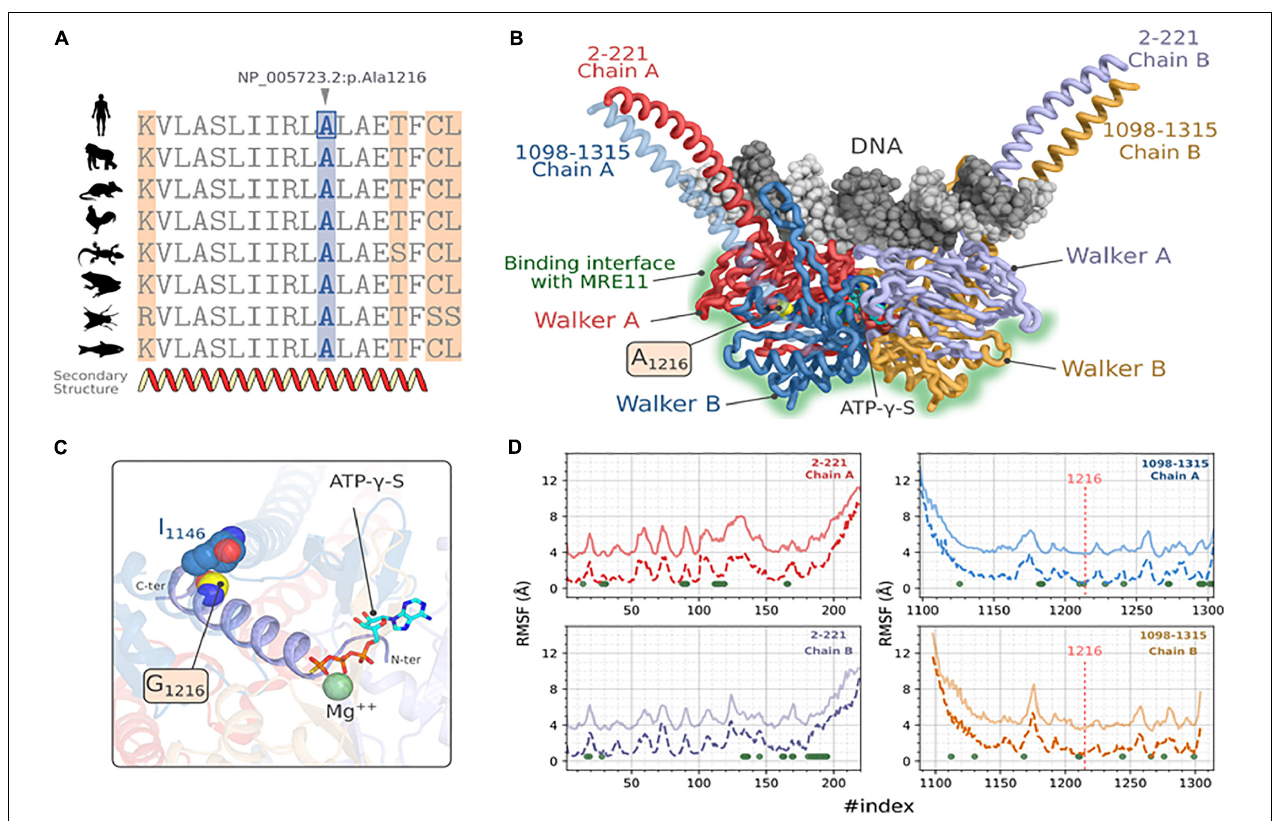
FIGURE 3 | Molecular modeling and stability analysis of RAD50_p.Ala1216Gly variation. (A) Multiple sequence alignment of hRAD50 with homologous proteins from model organisms, Gorilla (XP_004042521.1), Mus musculus (NP_033038.2), Gallus (XP_414645.3), Xenopus laevis (NP_001154855.1), Danio rerio (XP_005167995.1), Anolis carolinensis (XP_003217435.1) and Drosophila melanogaster (NP_001246461.1). (B) Predicted 3D structure of hRAD50 predicted with comparative modeling showing the mutation site and the different domains of the protein. DNA docking was generated by transferring the coordinates of the nucleic acid after a structural superposition of the symmetric chains. (C) Position of the mutation A1216G on the ATP γ S:Mg ++ stabilizing α -helix extended over residues 1203-1221. (D) Comparative RMSF analysis between the reference protein (A1216, solid lines) and the mutated protein (G1216, dashed lines). The values of RMSF for the reference protein were shifted to +3 Å. For the sake of visibility. The green dots represent the position where p-values are significant at a confidence level α = 0.05.